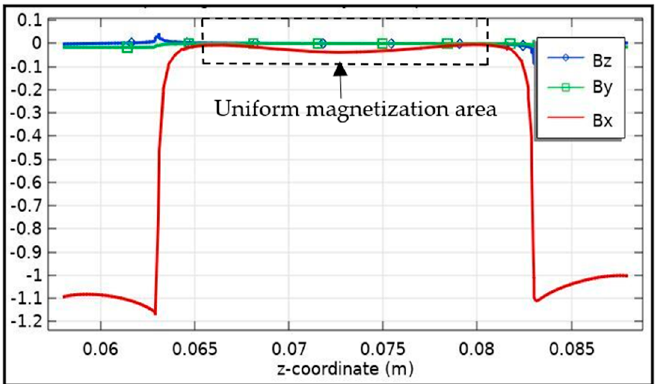
Figure 4. Line graph: The magnetic flux density (Bx, By, and Bz component) distribution in the pipe wall.